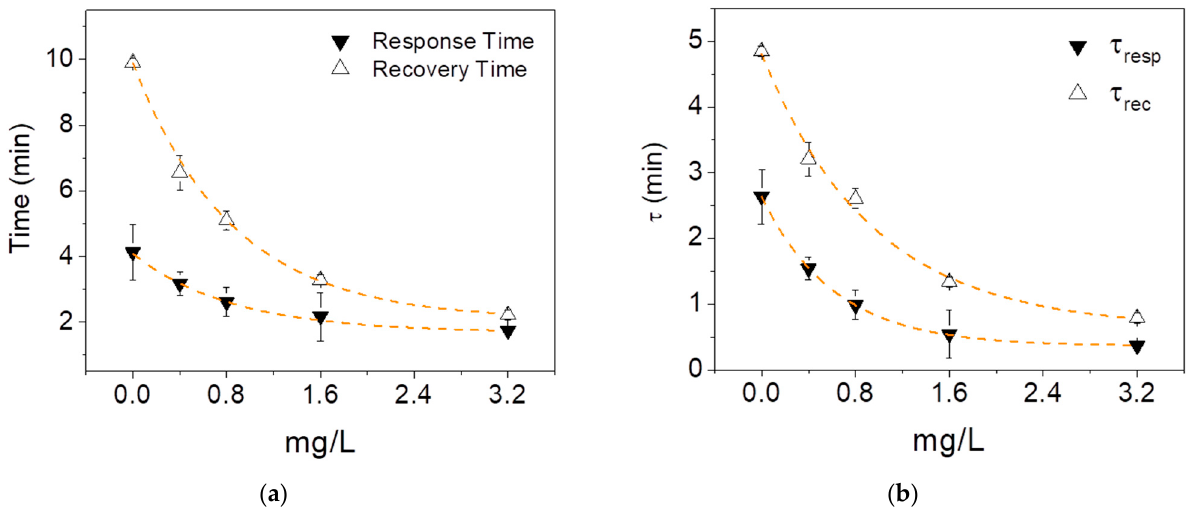
Figure 6. Time parameters for sensor exposed at different concentration of diacetyl in alcoholic solution and a CO 2 environment; ( a ) sensor response and recovery times at different diacetyl concentration; ( b ) plot of time constants as a function of diacetyl concentration. Error bars are calculated on three runs.